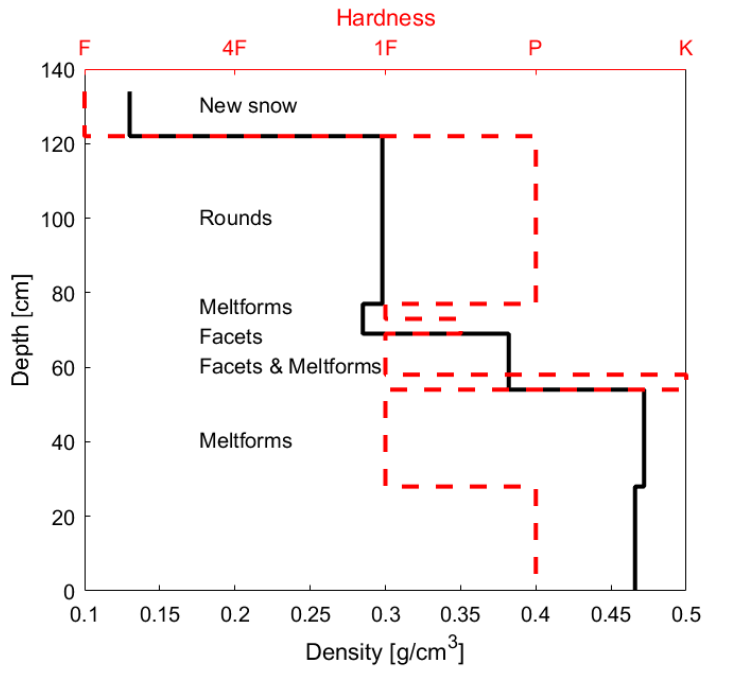
Figure 9. Vertical profile of in situ snow density (black), hardness (red dashed line), and grain type